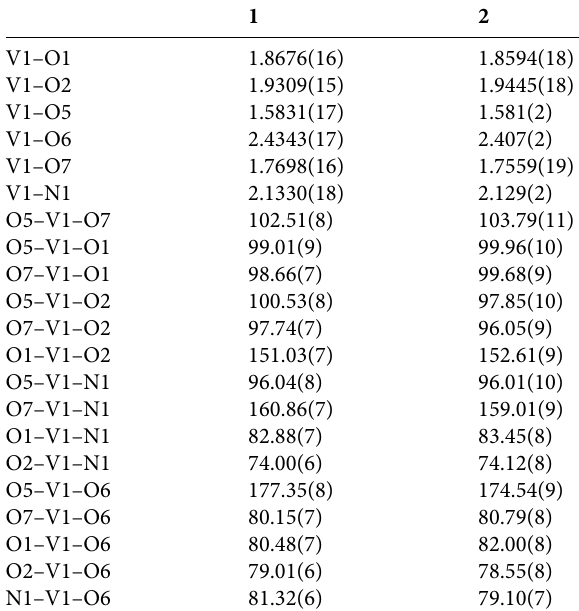
Table 2. Selected bond distances (Å) and angles (°) for the complexes